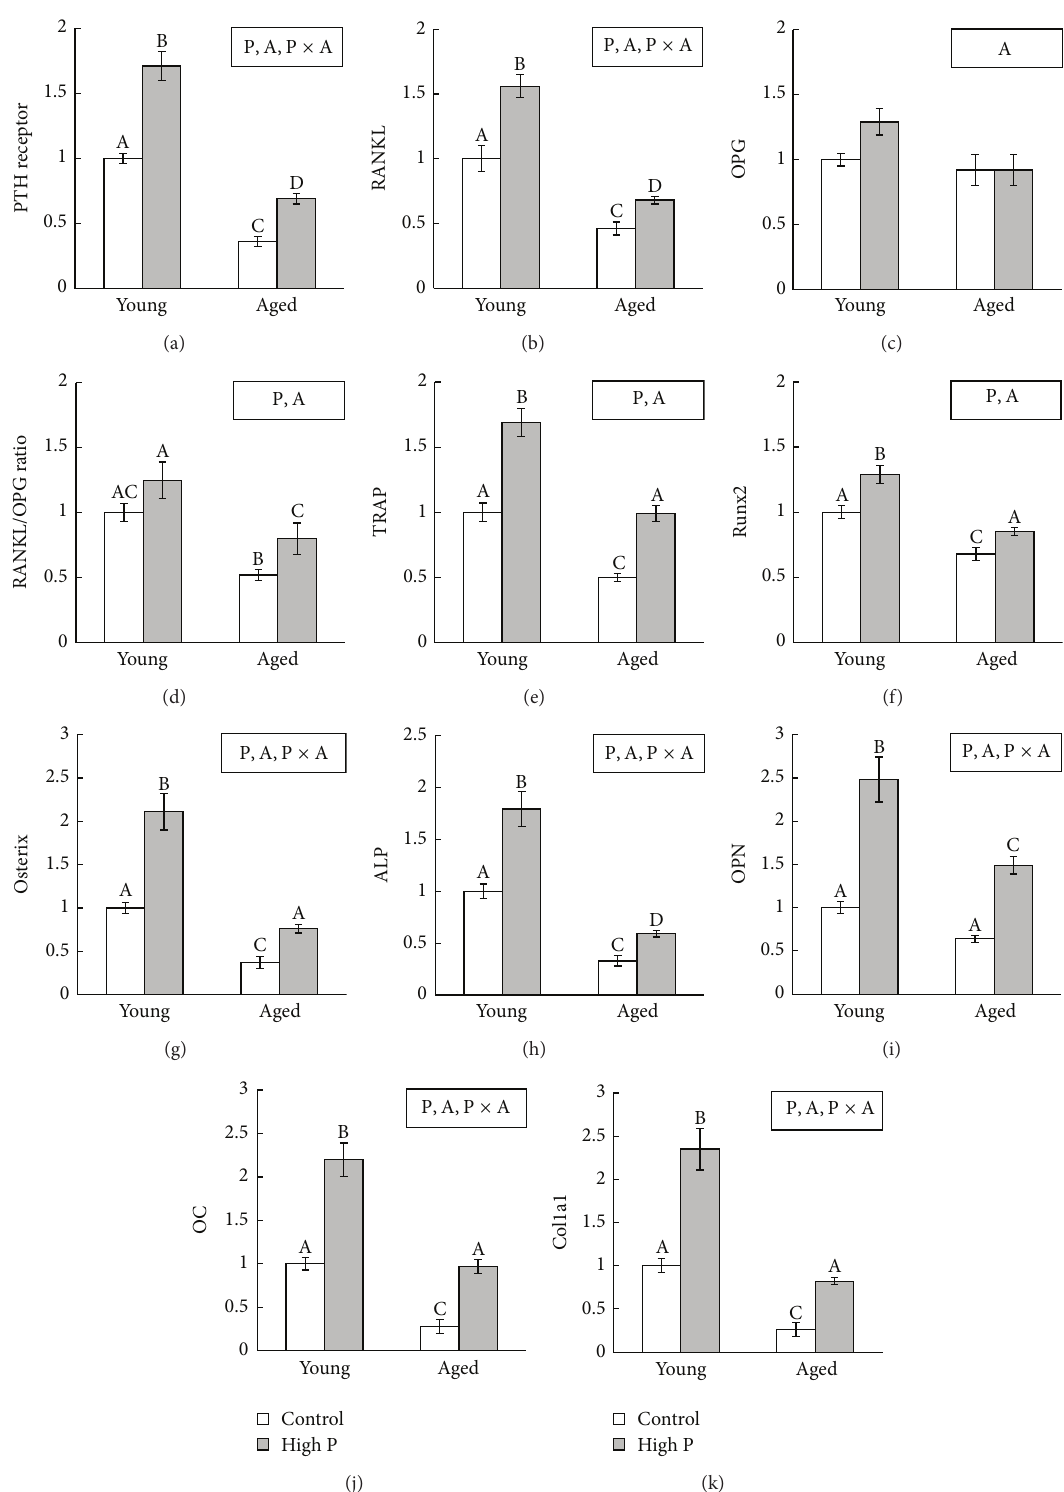
Figure 1: Bone metabolism-related gene expression in the femur. (a) PTH receptor; (b) RANKL; (c) OPG; (d) RANKL/OPG ratio; (e) TRAP; (f) Runx2; (g) Osterix; (h) ALP; (i) OPN; (j) OC; (k) Col1a1. The data indicate the mean ± SEM of 6 mice. A , B , C , D The different letters denote significant differences ( 𝑃 < 0.05 ). Significant effect ( 𝑃 < 0.05 ): P = effect of high P diet; A = effect of age; P × A = effect of interaction. The value of young mice fed a control diet is considered to be